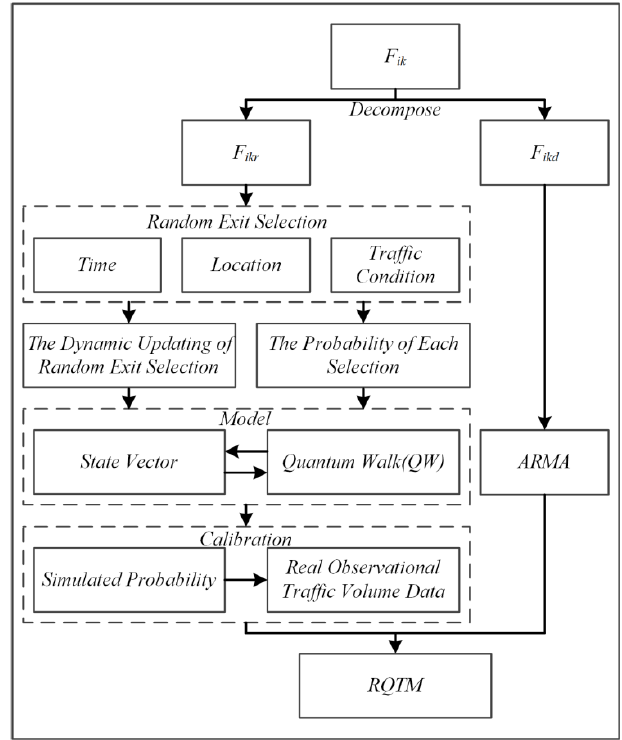
Figure 2. The overall framework.